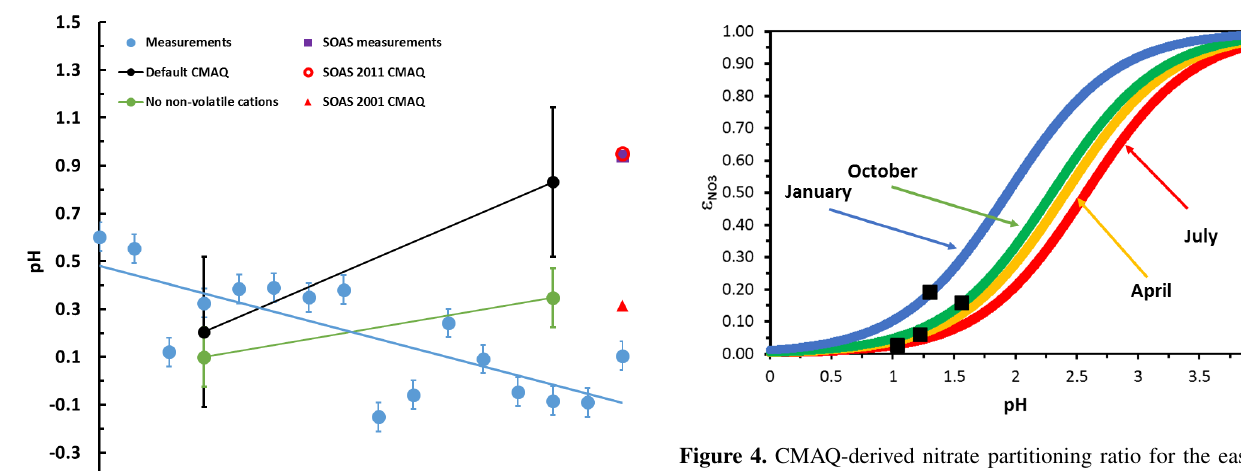
Figure 4. CMAQ-derived nitrate partitioning ratio for the eastern USA and select months of 2001. The black squares denote the av- erage pH values for each month. Note the insensitivity of nitrate partitioning to pH biases in the summer for pH values of less than 1 (cid:16) ∂ε (cid:17) NO3 ∼ 0 , which is not the case for colder ∂ pH